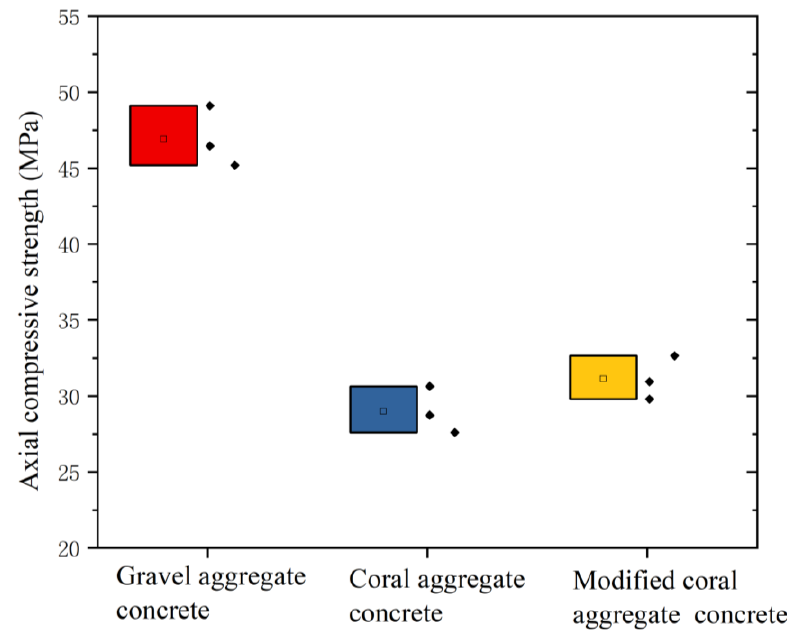
Figure 14. Axial compressive strength of specimens.